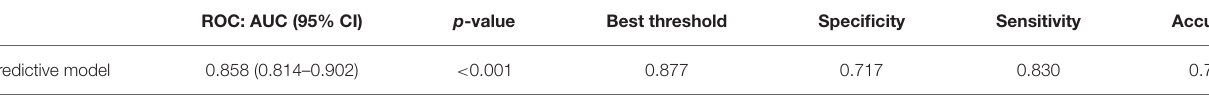
TABLE 4 | Predictive ability of the model.